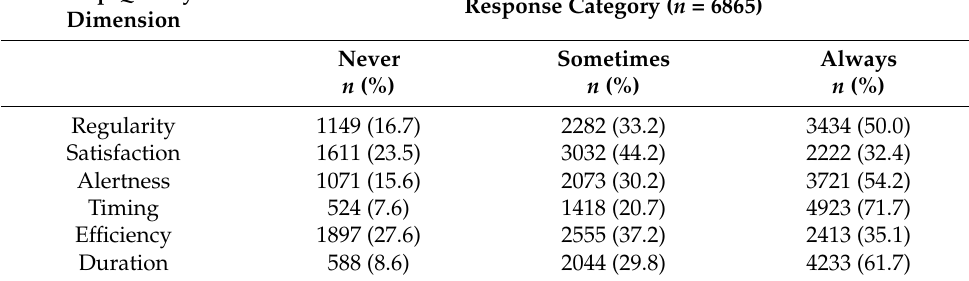
Table 5. Sleep quality in the general population during